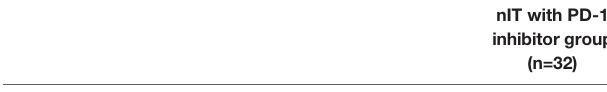
TABLE 1 | Baseline demographic and clinical characteristics of patients with dMMR/MSI-H